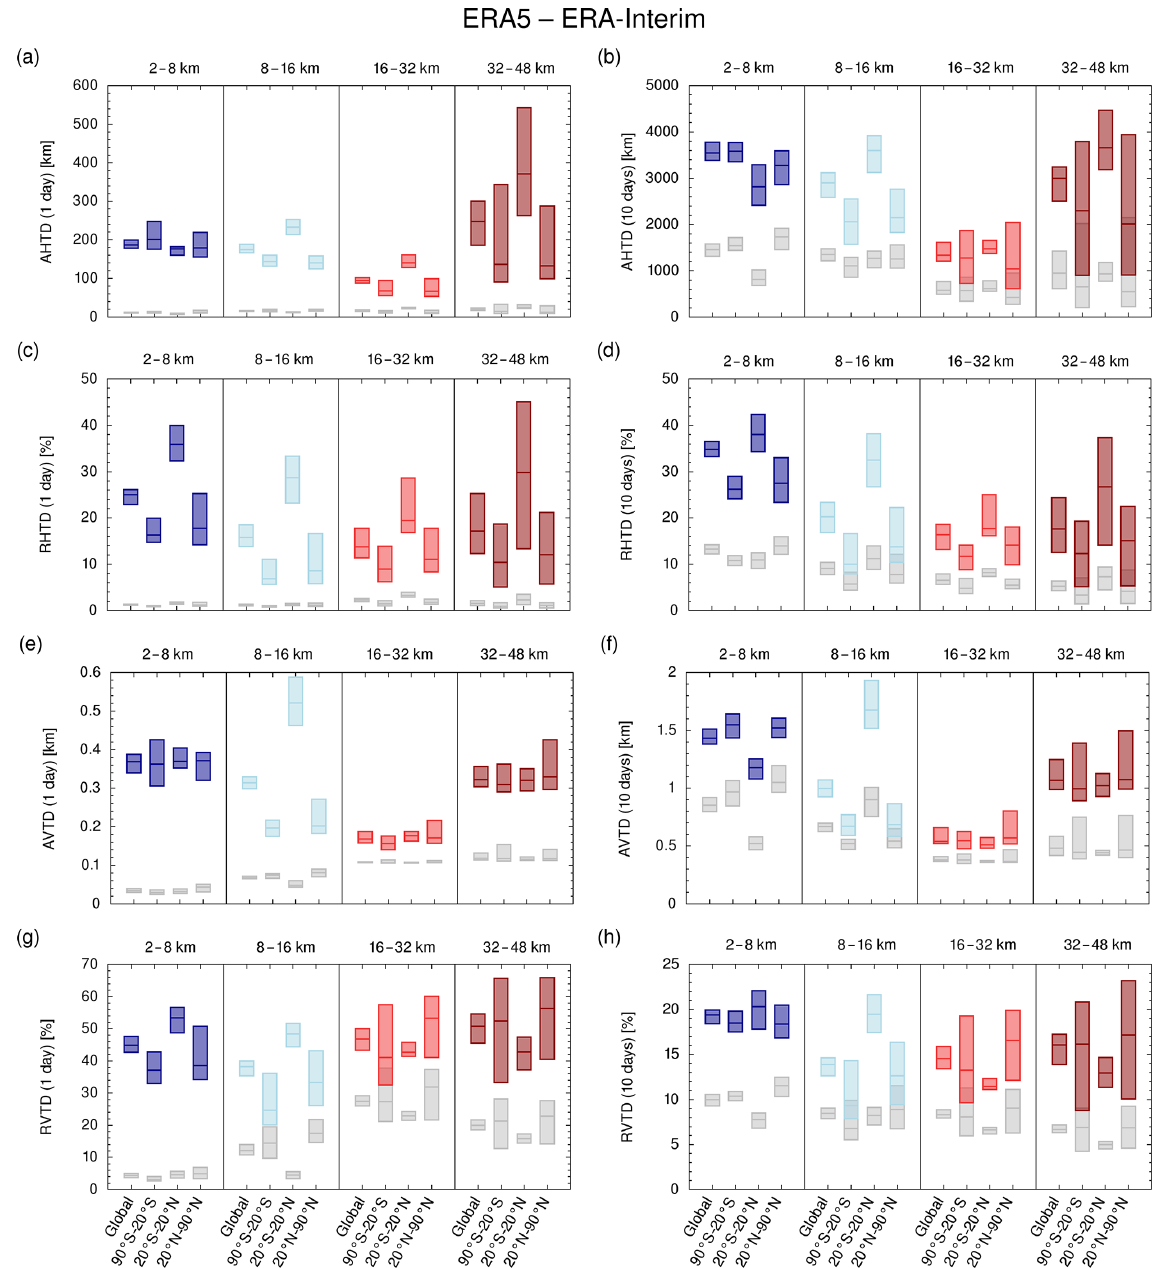
Figure 8. Transport deviations between ERA-Interim and ERA5 forward trajectories (blue and red bars for different height ranges) and transport deviations due to parameterized diffusion and subgrid-scale wind fluctuations (corresponding light gray bars) after 1 day (a, c, e, g) and 10 days (b, d, f, h) of simulation time. The bars indicate the peak-to-peak range and the median of 24 trajectory simulations covering the year